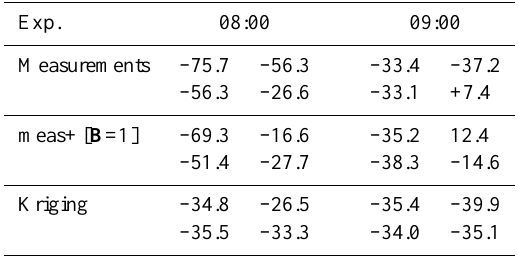
Table 2. Difference in % between the optimized and the true fluxes for three types of inversion constraints with (cid:15) E =–50% and (cid:15) m =10%. Exp.